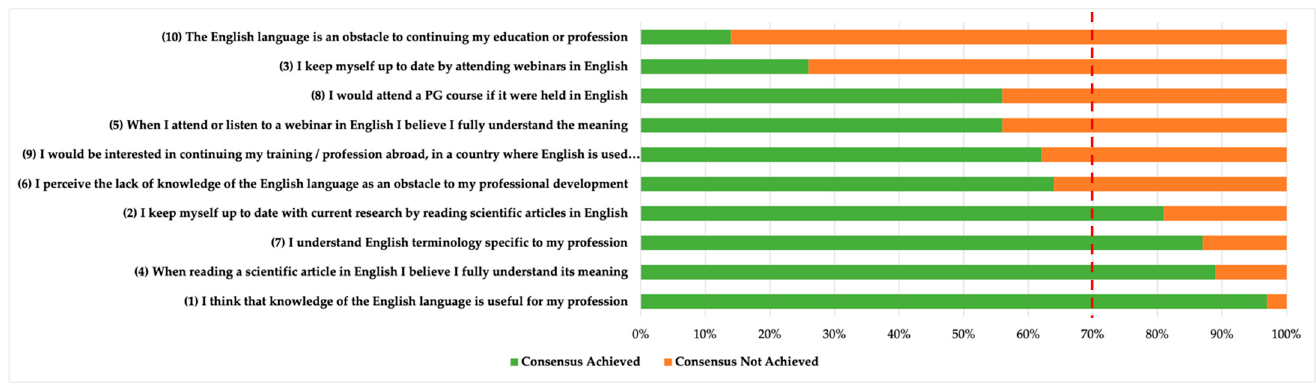
Figure 1. Level of consensus among UGs and PGs. Note: the red line represents the 70% level of